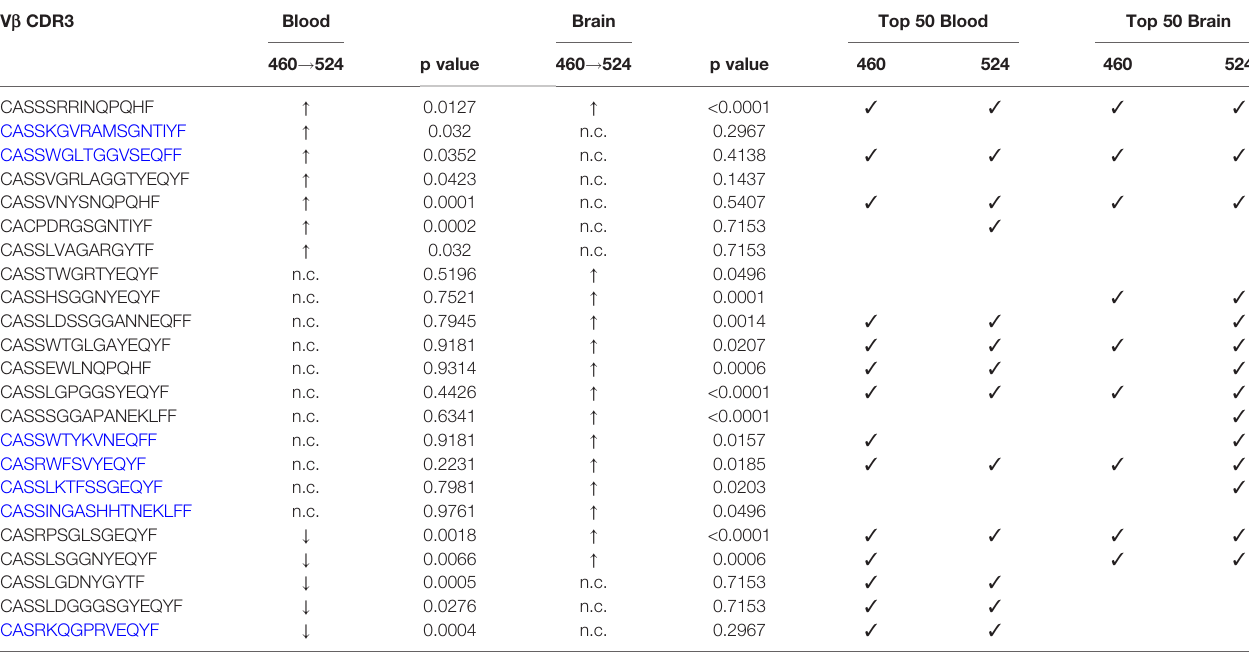
TABLE 3 | Changes in the frequencies of T cell clonotypes in blood and brain specimens from the fi rst and second surgeries. V b